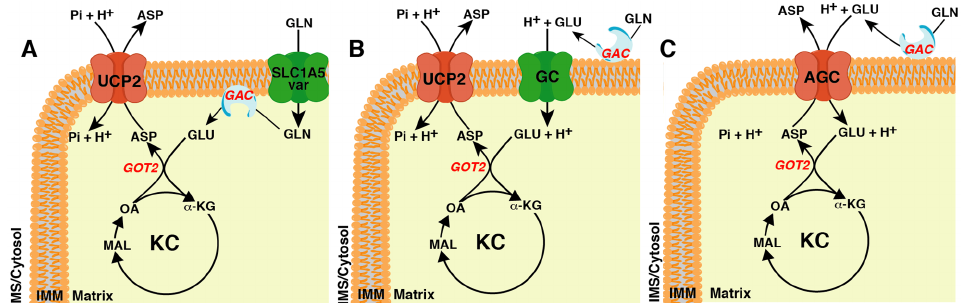
Figure 1. The different transporters involved in cytosolic glutamine-derived aspartate availability based on submitochondrial localization of glutaminase. ( A ) The localisation of glutaminase (GAC) at the matrix side of the inner mitochondrial membrane (IMM) requires the glutamine transporter and the aspartate/Pi + H + exchanger (uncoupling protein 2, UCP2). ( B ) The localisation of GAC at the external side of the IMM requires the glutamate + H + transporter (GC) and UCP2. ( C ) The localisation of GAC at the external side of the IMM requires only the aspartate/glutamate + H + carrier (AGC). ASP, aspartate; GLN, glutamine; GLU, glutamate; Pi, phosphate; OA, oxaloacetate; MAL, malate; α -KG, α -ketoglutarate; KC, Krebs cycle; IMS, intermembrane space; GOT2, mitochondrial isoform of the glutamate-oxaloacetate